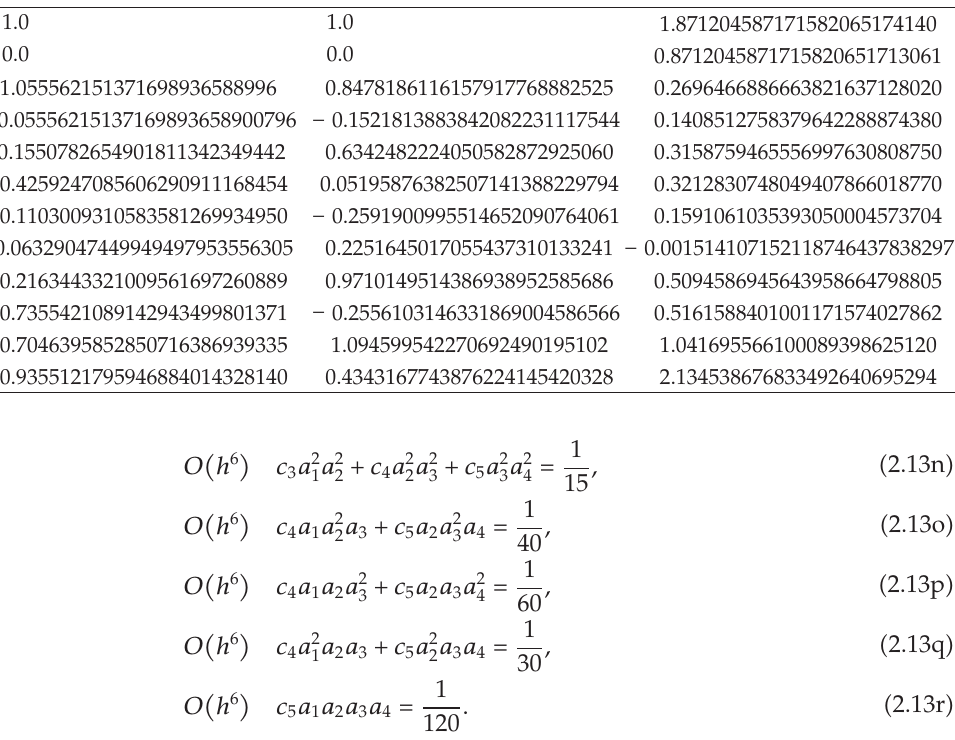
Table 4: Optimized ARK5 parameter